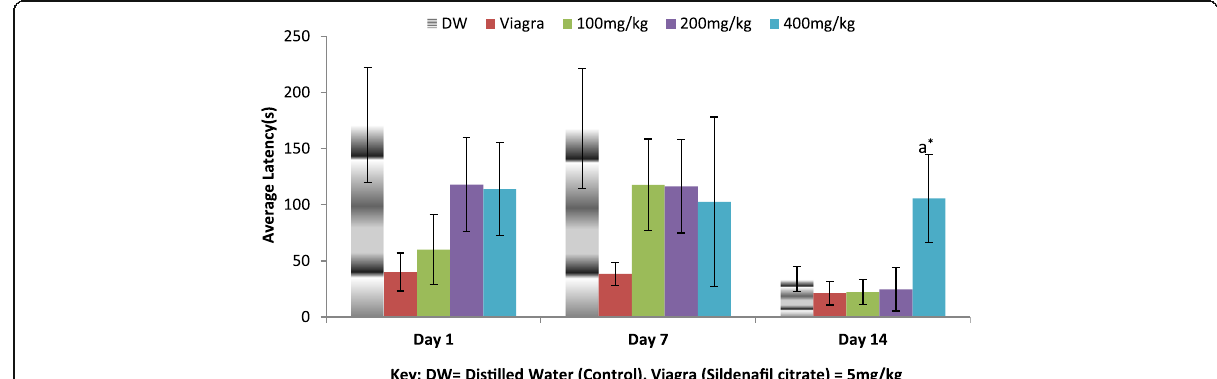
Fig. 4 Effect of ethanol extract of A. barbadensis root on intromission latency of male rats. Bars with different letters are significantly different; bars with letters are significantly different from bars without letters while those with no letters are not significantly different from each other on each day. Bars with different numbers for the same dose group at different days are significantly different while those without numbers are not significantly different. All values are expressed as Mean ± SEM; n = 5;** P < 0.01; * P < 0.05